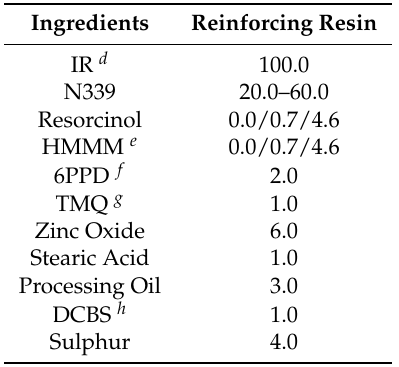
Table 1. Recipe for the carbon-black-type series used in this study (all values in parts per hundred rubber). Ingredients N121 N339 N550 SSBR a 100.0 100.0 100.0 Filler 0.0–55.0 0.0–55.0 0.0–75.0 IPPD b 1.5 1.5 1.5 Zinc Oxide 3.0 3.0 3.0 Stearic Acid 1.0 1.0 1.0 CBS c 2.0 2.0 2.0 Sulphur 1.4 1.4 1.4